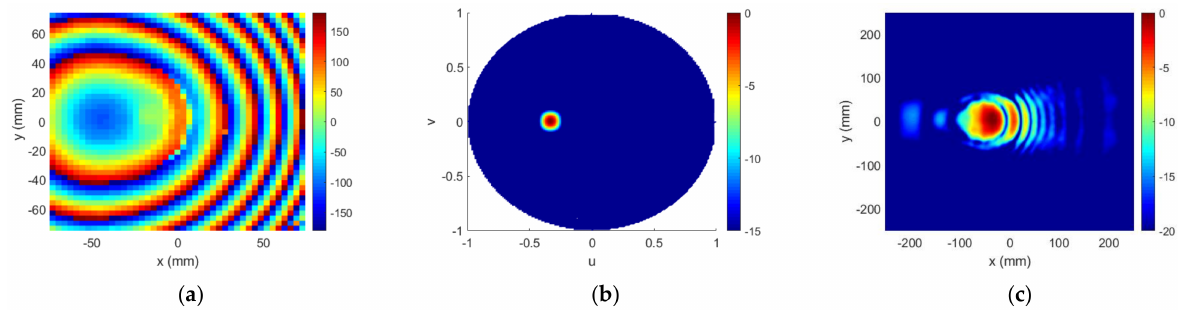
Figure 13. Case 2, outputs of Stage#1: ( a ) required phase φ (cid:48) ( c ) NF distribution E (cid:48) NF (dB) on plane z = 0.6 D